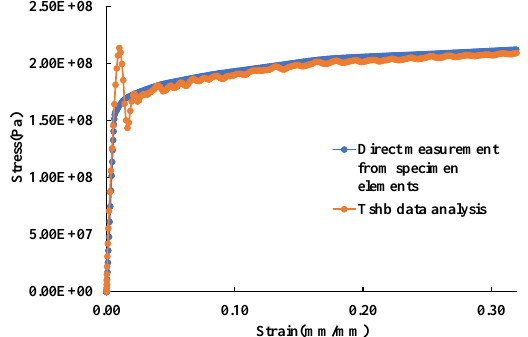
The computed shear stress- shear strain from TSHB formulation using strain data taken from incident and transmission bar and the direct measurement from specimen are presented in Fig.11. The specimen shear stress-shear strain from perfect bond and specimen held in slot are in complete alignment. The slight disturbance which can be neglected is coming from contact interaction. The strain pulses from the incident bar and transmission bar from slot gripping case is also compared with other two cases in next section.